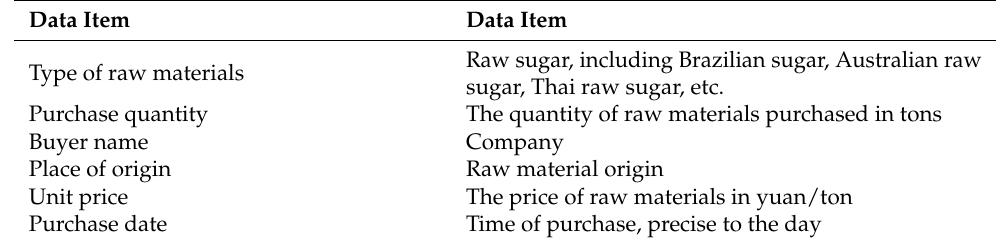
Table 1. Raw material purchase data set description.